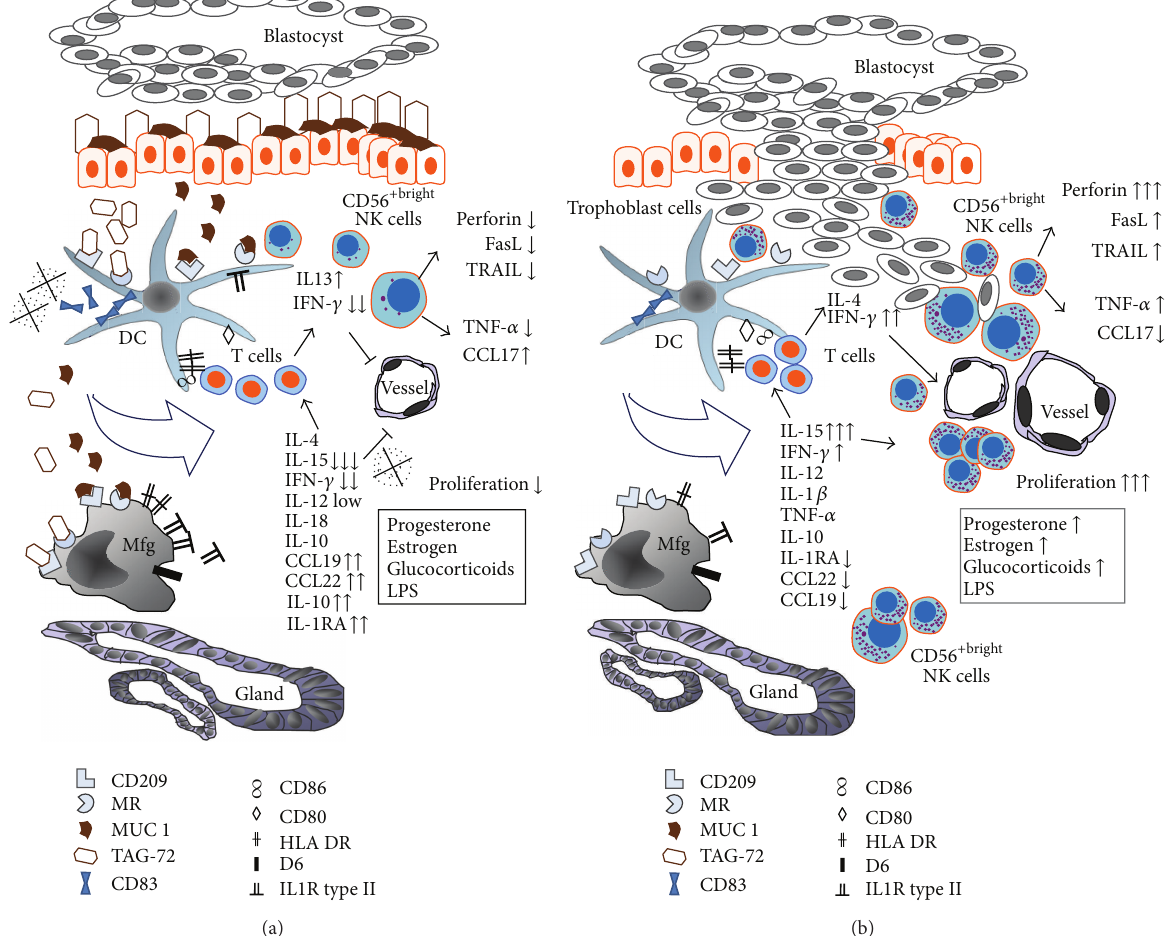
Figure 1: Proposed model for antigen-presenting cells and decidual lymphocytes interactions at the maternal-foetal interface in the presence (a) and absence (b) of mucin-1- (Muc 1-) and tumour-associated glycoprotein-72 (TAG-72). The functions of dendritic cells (DCs) and macrophages (Mfgs) may be influenced by Muc 1 and TAG-72 that bind to the mannose receptor (MR) and CD209. TAG-72-shaped DCs may produce less CD83, resulting in lower proliferation and selective apoptosis of cognate cytotoxic T cells to allow survival of Th2-oriented T cells with low production of IFN-gamma (IFN- 𝛾 ), attracted by CC chemokine ligand- (CCL-)19 and CCL22. Mfgs in the presence of TAG- 72 produced higher levels of interleukin (IL)-10 and IL-1 receptor antagonist (IL-1RA), but significantly decreased levels of IL-12 and CCL3, supportaTh2bias.Muc1-shapedMfgsincreasedIL-1receptortypeII(IL-1RtypeII)expression,whereasaD6decoy,CD80,CD86,andhuman leukocyte antigen (HLA)DR remain relatively unchanged. Muc 1-shaped Mfgs and TAG-72-treated DCs appear to decrease IL-15 production and cannot support the proliferation of CD56 bright NK cells and expression of cytotoxic mediators. Low IFN- 𝛾 expression by TAG-treated DCs does not support decidual vessel remodelling. During normal eutopic implantation, removing surface epithelial glycoproteins (b) allows antigen-presenting cells to support mild proinflammatory reactions by increasing IL-15 and IFN- 𝛾 production and amplifying NK cells, which are rich in cytotoxic